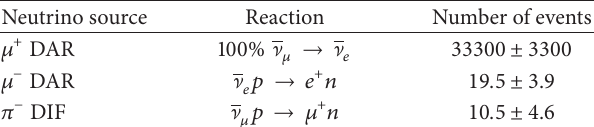
Table 2: The LSND estimated number of events in the 20 < 𝐸 𝑒 < 60 MeV energy range due to 100% ] the two beam-related backgrounds with neutrons, 𝜇 − DAR in the beam stop followed by ] 𝑒 𝑝 → 𝑒 + 𝑛 scattering in the detector and 𝜋 − DIF in the beam stop followed by ] events must satisfy the electron selection criteria, but no correlated 𝛾 requirement is